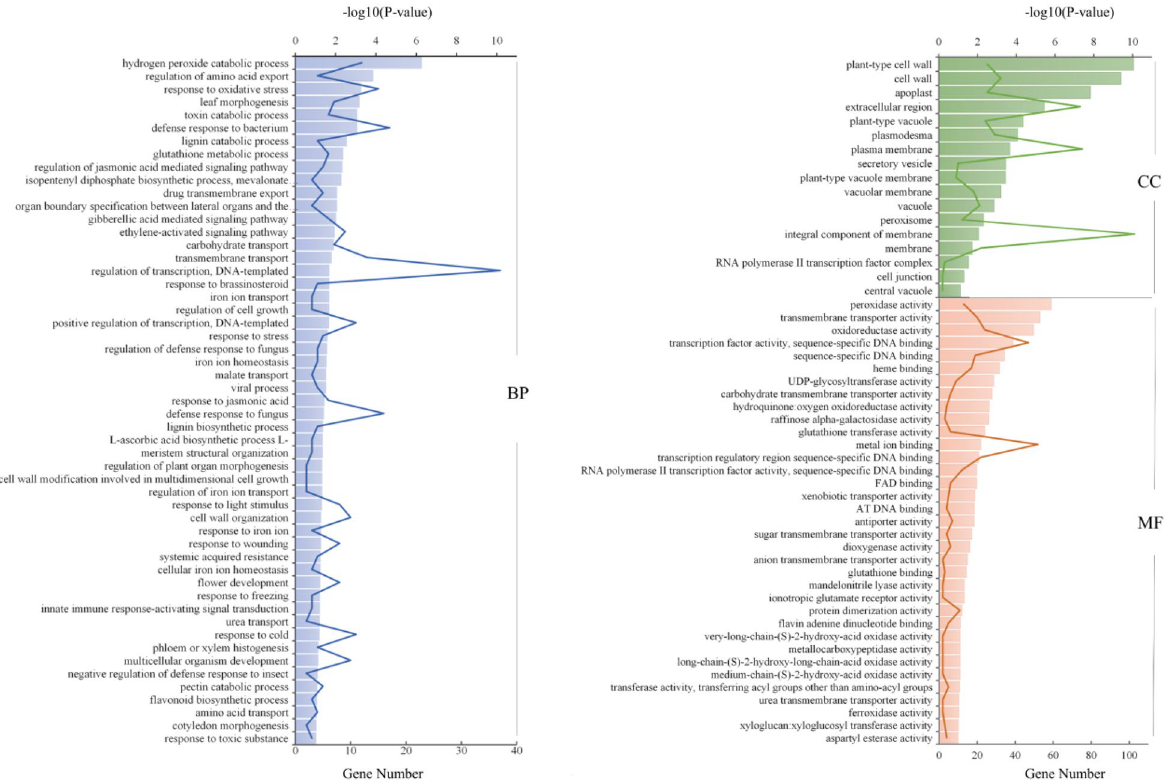
Figure 5. Statistics of GO annotation classification for the DEGs in s0 vs s1 and s0 vs s2. The bar chart represents the − log10 (P-value) of differential genes, line chart represents the number of Gene Ontology (GO)